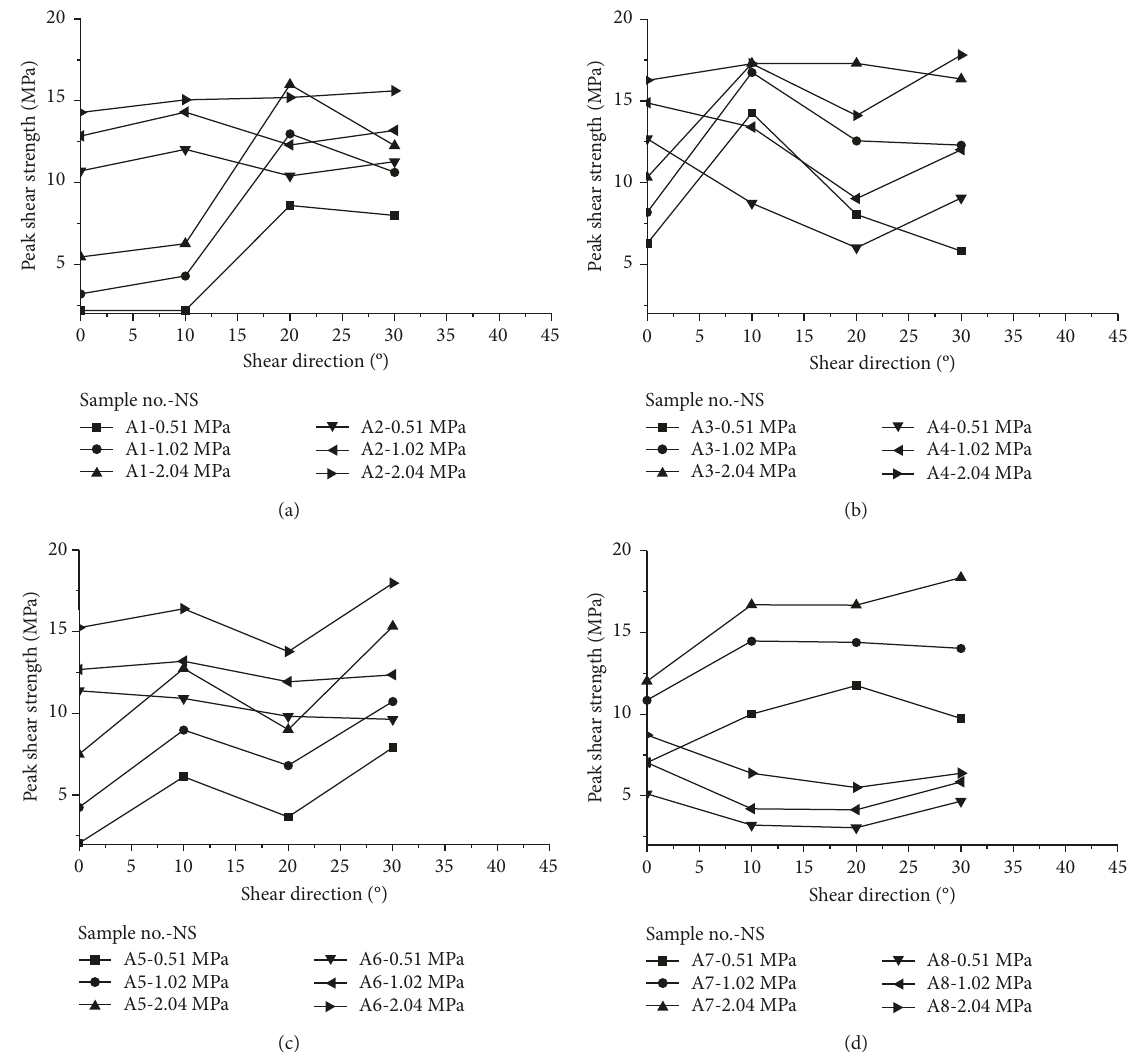
Figure 20: Relationship between peak shear strengths and shear directions for the subsamples of natural rough rock joint surfaces. (a) A1 and A2; (b) A3 and A4; (c) A5 and A6; (d) A7 and